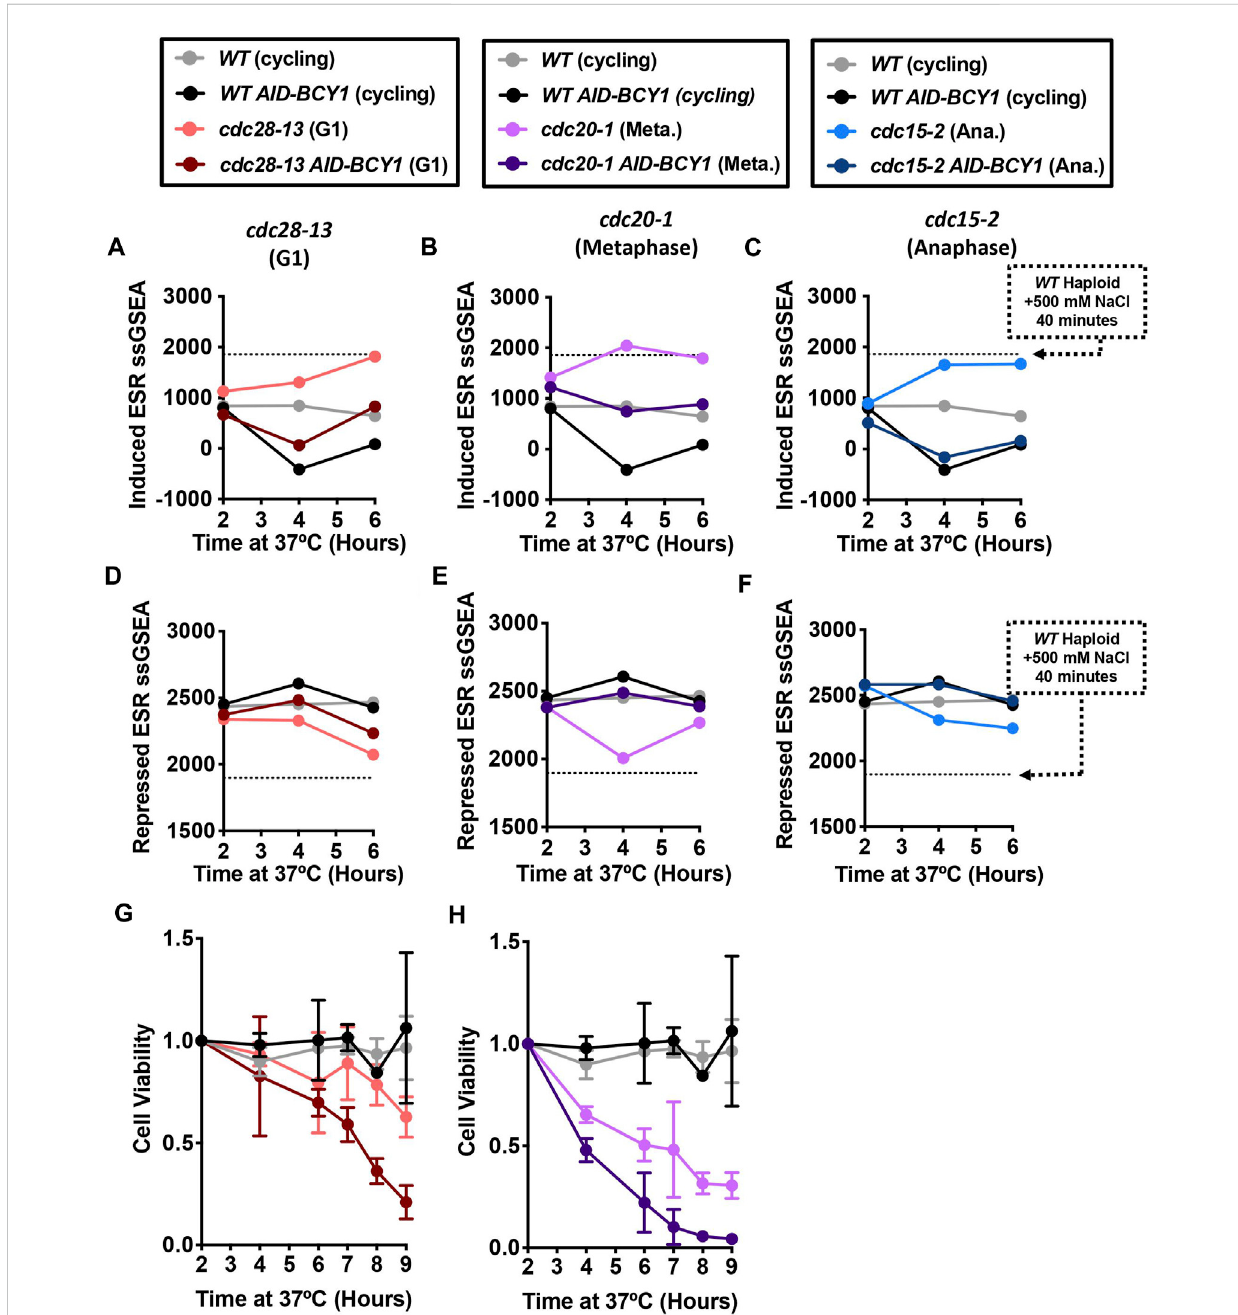
FIGURE 4 Hyperactivation of the Ras/PKA pathway suppresses the ESR and reduces the viability of cell cycle-arrested cells. WT (A2587), WT AID-BCY1 (A40439), cdc28-13 (A39000), cdc28-13 AID-BCY1 (A40444), cdc20-1 (A937), cdc20-1 AID-BCY1 (A40499), cdc15-2 (A2596), and cdc15-2 AID-BCY1 (A40501) cells weregrown to log phase in YEPD (supplemented with 138 μ Lglacial acetic acid for each 1 LYEPD) at25 ° C and then shifted to 37 ° C for 6 h. WT and WTAID-BCY1 cultureswerekeptinlogphase,termedcycling,atOD – 0.8,bydilutingwithpre-warmed(37 ° C)YEPD(supplemented 600nm 0.2 with acetic acid). The auxin analogue IAA (500 μ M) was added after 2 h and 4 h at 37 ° C. (A – C) Induced ESR ssGSEA projection values calculated from RNA-Seq gene expression data of the indicated strains and arrest timepoints. (D – F) Repressed ESR ssGSEA projection values calculated from RNA-Seq gene expression data of the indicated strains and arrest timepoints. WT ad WT AID-BCY1 data shown in A-F are from the same experiment. (G – H) Cell viability was measured for the indicated strains during a 9 h cell cycle arrest. Cells were plated and colony forming units were determined for each timepoint and normalized to the 0-h time point of each experiment. Error bars represent range of two experimental replicates. The same data for WT ad WT AID-BCY1 are shown in G-H for